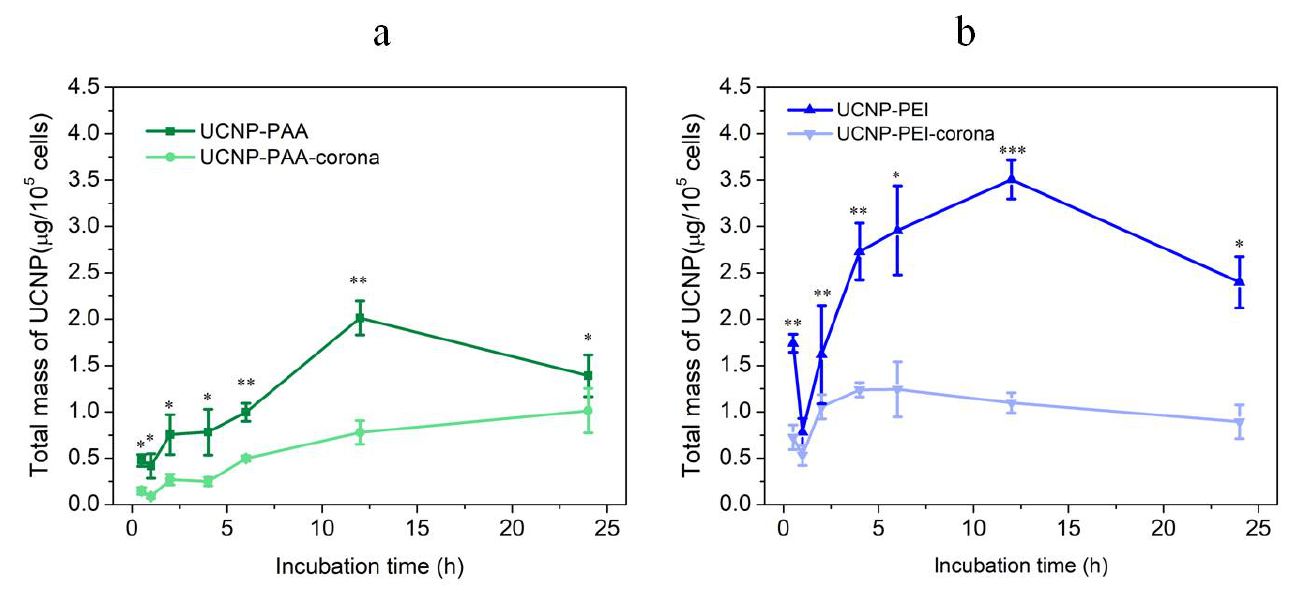
Figure 6. Kinetics of the bare and PC-coated UCNP-PAA ( a ) and UCNP-PEI ( b ) association with MDA- MB-231 cells as assayed by ICP-MS in terms of the total mass of UCNP taken at the concentration of 10 µ g/mL per 10 5 cells. Each value represents a mean of triplicate experiments ± standard deviation. Statistical significance was designated with * p < 0.05, ** p < 0.01, and *** p <